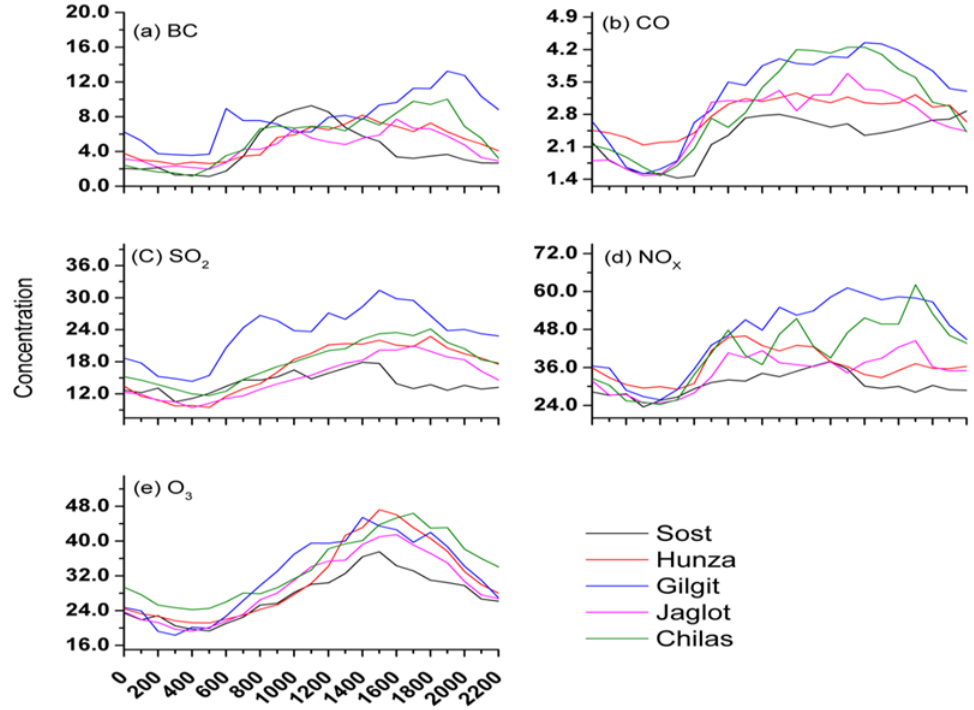
Figure 6. Diurnal variation of ( a ) BC (in µg/m 3 ), ( b ) CO (in mg/m 3 ), ( c ) SO 2 (in µg/m 3 ), ( d ) NO X (in µ g/m 3 ) and ( e ) O 3 (in µg/m 3 ) at selected study sites in Gilgit-Baltistan during summer, 2020.